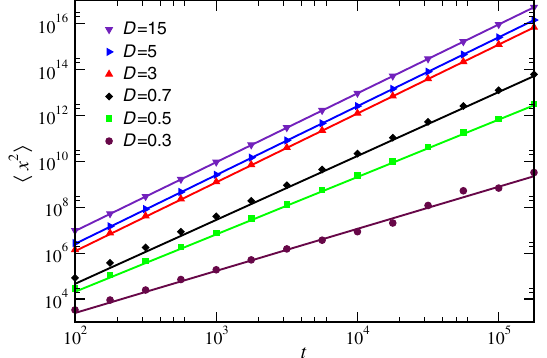
FIG. 8. Simulations and theory for the mean-square displace- ment versus time nicely match without fitting. The D > 1 Obukhov phase yields h x 2 i ∝ t 3 scaling; hence, for D ¼ 15 , 5, 3 the curves are parallel. In the Lévy phase 1 = 5 < D < 1 , diffusion is anomalous with an exponent that is D and hence U 0 dependent. For D ¼ 0 . 3 , we see relatively large fluctuations, possibly due to the nearby transition to the Gaussian phase. Here, we use a Langevin simulation, with a time step dt ¼ 0 . 1 , and average over 10 5 particles. Theoretical lines are based on Eqs. (89) and (93) and the excursion and meander areal variance, Eqs. (70) and